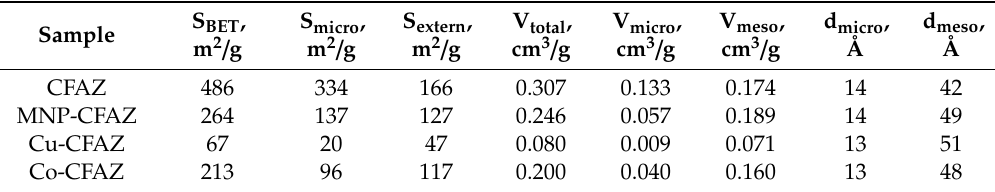
Table 1. Surface properties of nonmodified and modified CFAZs.